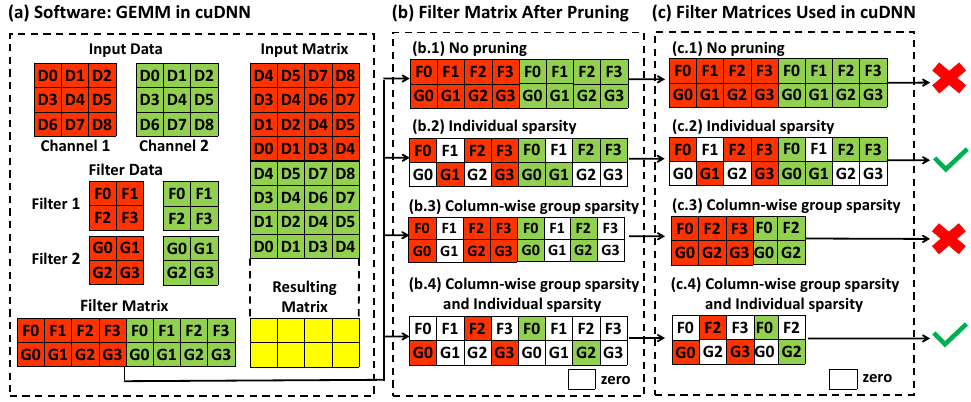
Figure 1. Observations of different strategies’ pruned filter matrix for hardware acceleration with software implementation of convolution in cuDNN. ( a ) General Matrix Multiply (GEMM) is ap- plied in cuDNN. ( b ) Different strategies such as no pruning, individual sparsity, column-wise group sparsity, and both individual sparsity and column-wise group sparsity on pruning the filter matrix. ( c ) The pruned filter matrix implemented in cuDNN and determined whether it can be used for hardware acceleration or